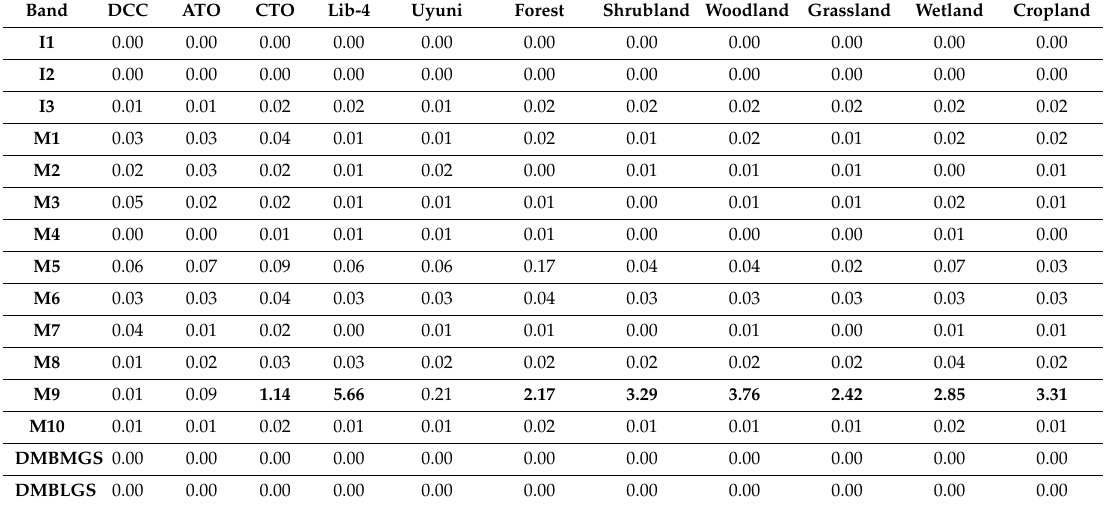
Table 9. JPSS-2 VIIRS V2 RSR Earth-reflected scene-dependent γ for specified 1% extended bandpass limits, shown in %.